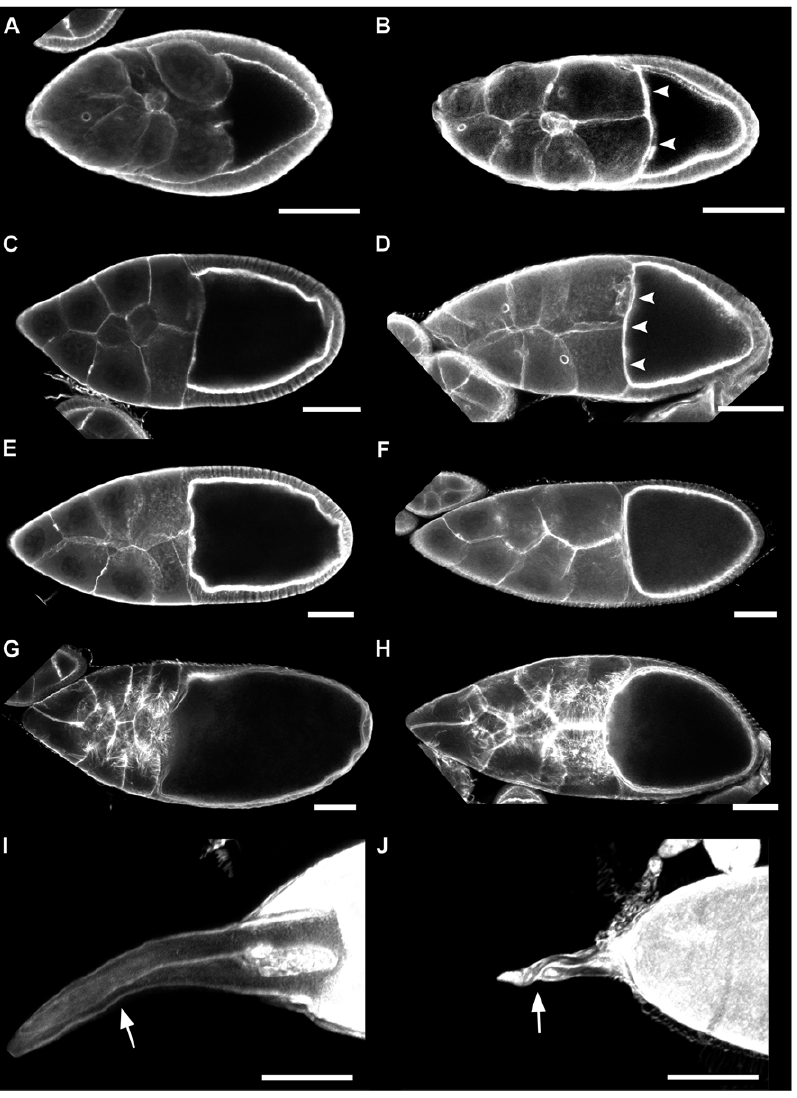
Figure 3. Developing egg chambers in lqfR mutants exhibit several morphological defects. Stage-matched TRITC-phalloidin stained egg chambers from wild type (A,C,E,G,I) and lqfR D66 (B,D,F,H,J) ovaries. (A,B) Mid-stage 9; (C,D), stage 10A; (E,F) stage 10B; (G, H) stage 11 (H is slightly earlier in stage 11 than G, but it exhibits the cuboidal follicular epithelium and actin cytoskeleton of stage 11); (I,J) stage 14, anterior end only. Arrowheads show increased anterior actin in stage 9 and 10A (B,D) lqfR mutant egg chambers. Dorsal appendages (arrows). Anterior is at left in all panels. A–H are single confocal slices. I and J are z-stack confocal projections. Bars, 50 m m.